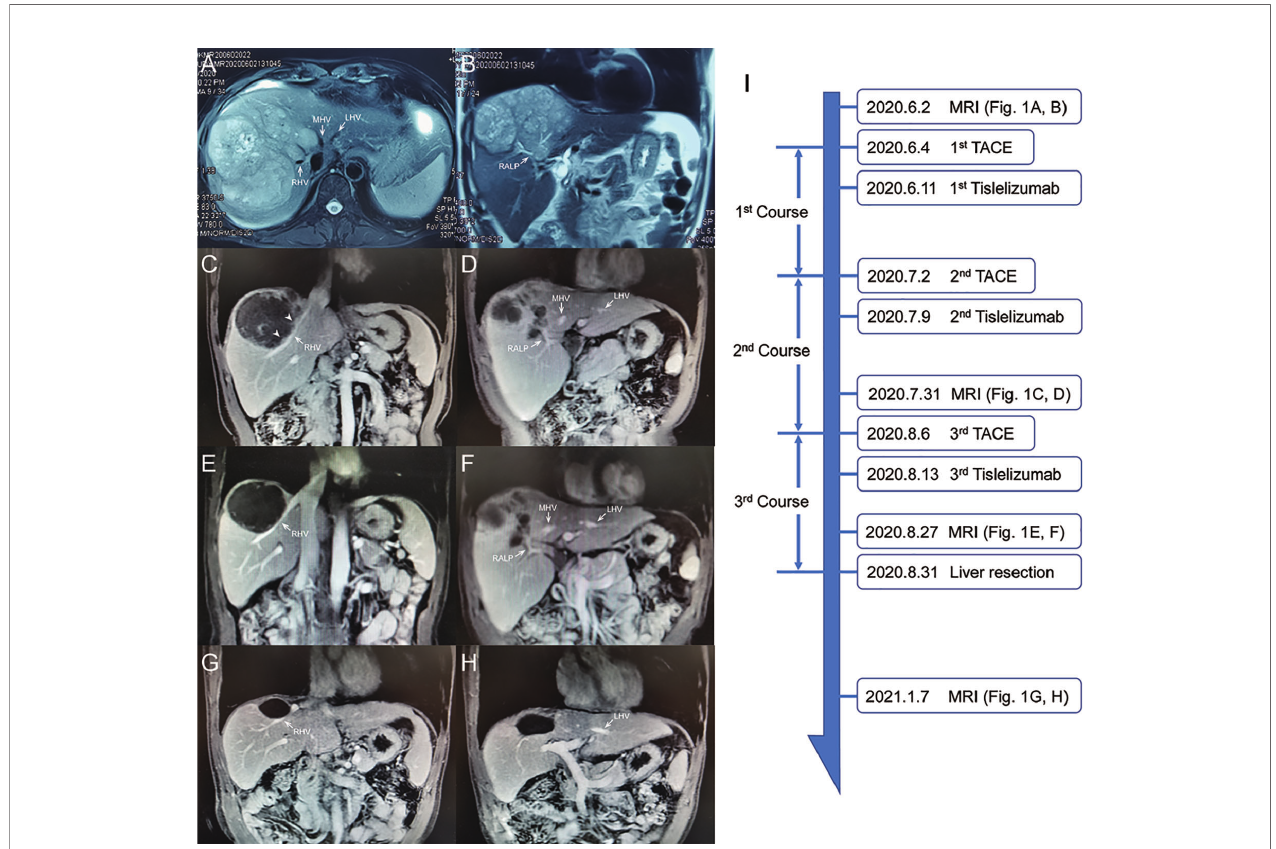
FIGURE 1 | Abdominal MRI scan at different treatment phases. (A, B) Images at initial diagnosis. (C, D) Images after 2 nd course. Arrowheads indicate viable tumor lesions near the RHV. (E, F) Images before surgery. (G, H) Images at 4-month after surgery. (I) Timeline of treatment process. RHV, right hepatic vein; MHV, middle hepatic vein; LHV, left hepatic vein; RALP, right anterior lobe pedicle.